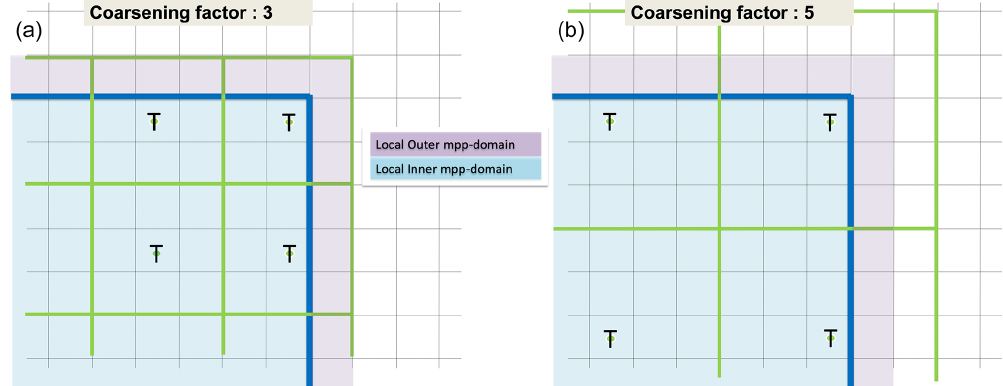
Figure 13. Position of coarsened cells (green), on their high-resolution grid local mpp domain, for a coarsening factor of 3 (a) and coarsening factor of 5 (b)